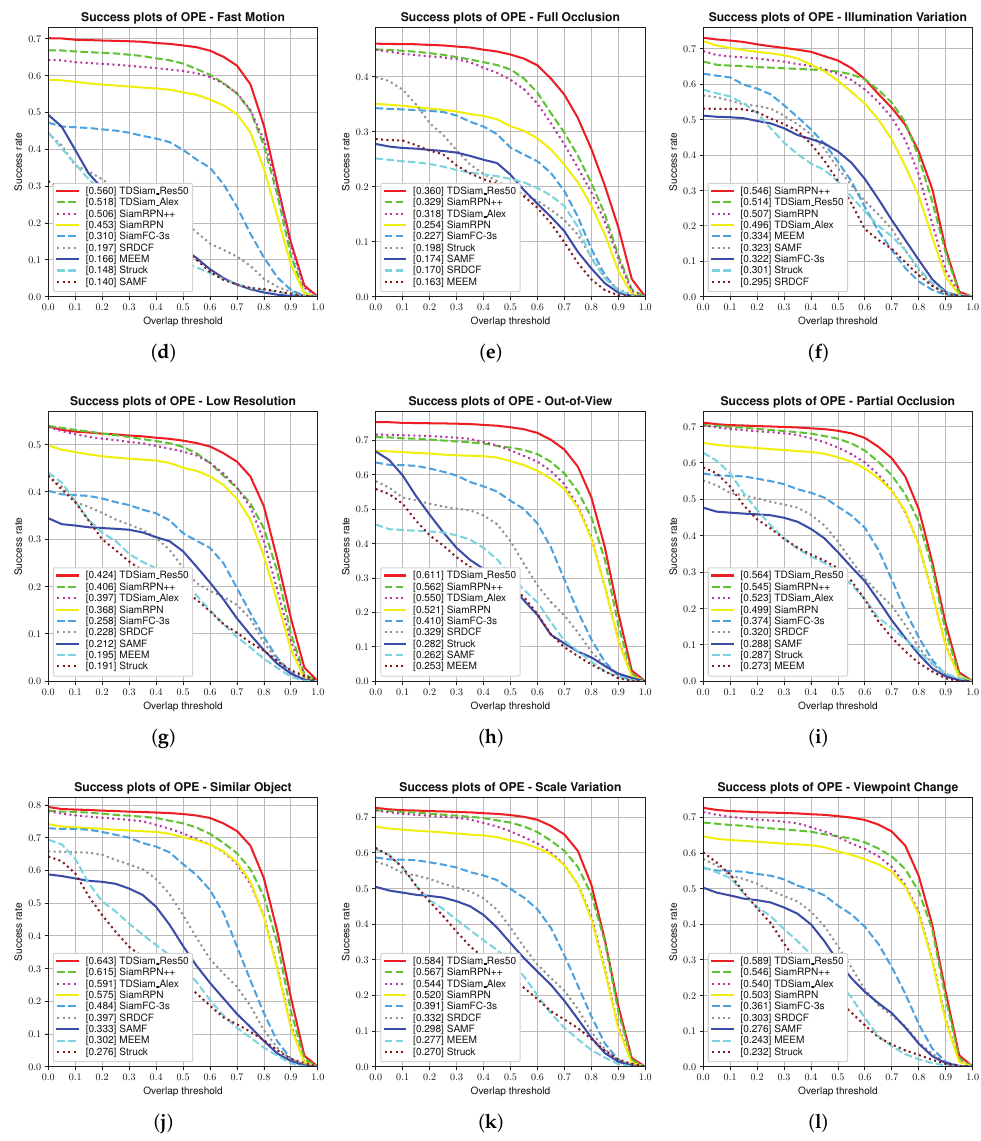
Figure 11. Success plots corresponding to some different scenarios. The UAV20L dataset was used for the evaluation. ( a ) Aspect Ratio Change; ( b ) Background Clutter; ( c ) Camera Motion; ( d ) Fast Motion; ( e ) Full Occlusion; ( f ) Illumination Variation; ( g ) Low Resolution; ( h ) Out of View; ( i ) Partial Occlusion; ( j ) Similar Object; ( k ) Scale Variation; ( l ) Viewpoint